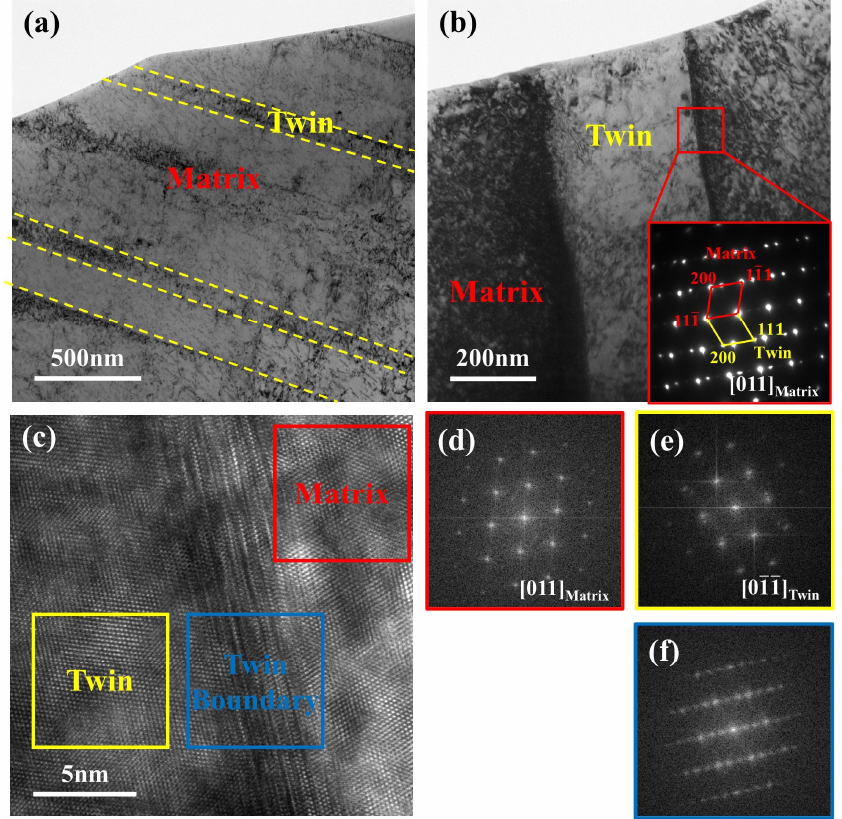
Figure 10. TEM micrographs of the CR-1023/4 Ni 2 CrFe alloys after tensile fracture at 293 K. ( a ) Bright-field (BF) image; ( b ) twin boundary and corresponding selected-area electron diffraction field (BF) image; ( b ) twin boundary and corresponding selected‑area electron diffraction (SAED); (SAED); ( c ) high-resolution TEM image of twin boundary; fast-Fourier-transformed images of ma- ( c )high‑resolution TEMimage of twinboundary; fast‑Fourier‑transformedimages of matrix( d ), twin trix ( d ), twin ( e ), and twin boundary ( f ). ( e ), and twin boundary ( f